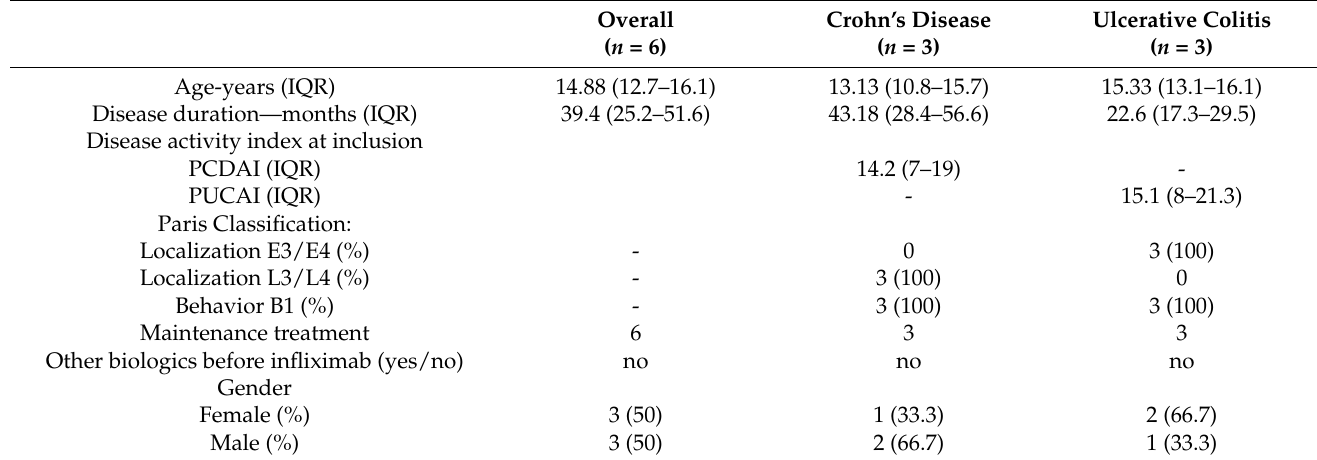
Table 2. ELISA measurements in the pediatric IBD cohort.